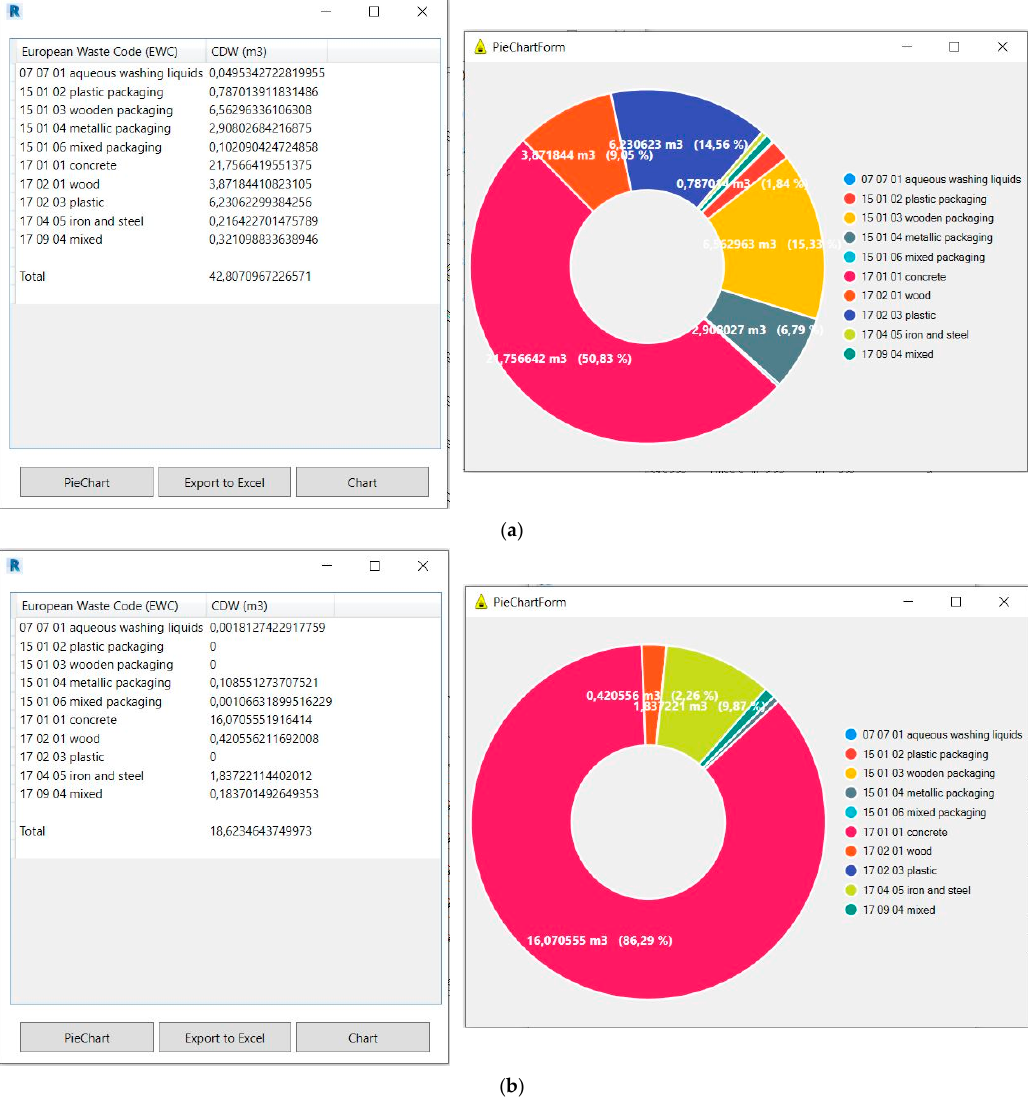
Figure 6. ( a ) CW quantification of the reinforced concrete structure (Option 1): total CW and PieChartForm, ( b ) CW quantification of the steel structure (Option 2): total CW and PieChartForm. Data expressed volume (m 3 ) and commas separate decimal places.